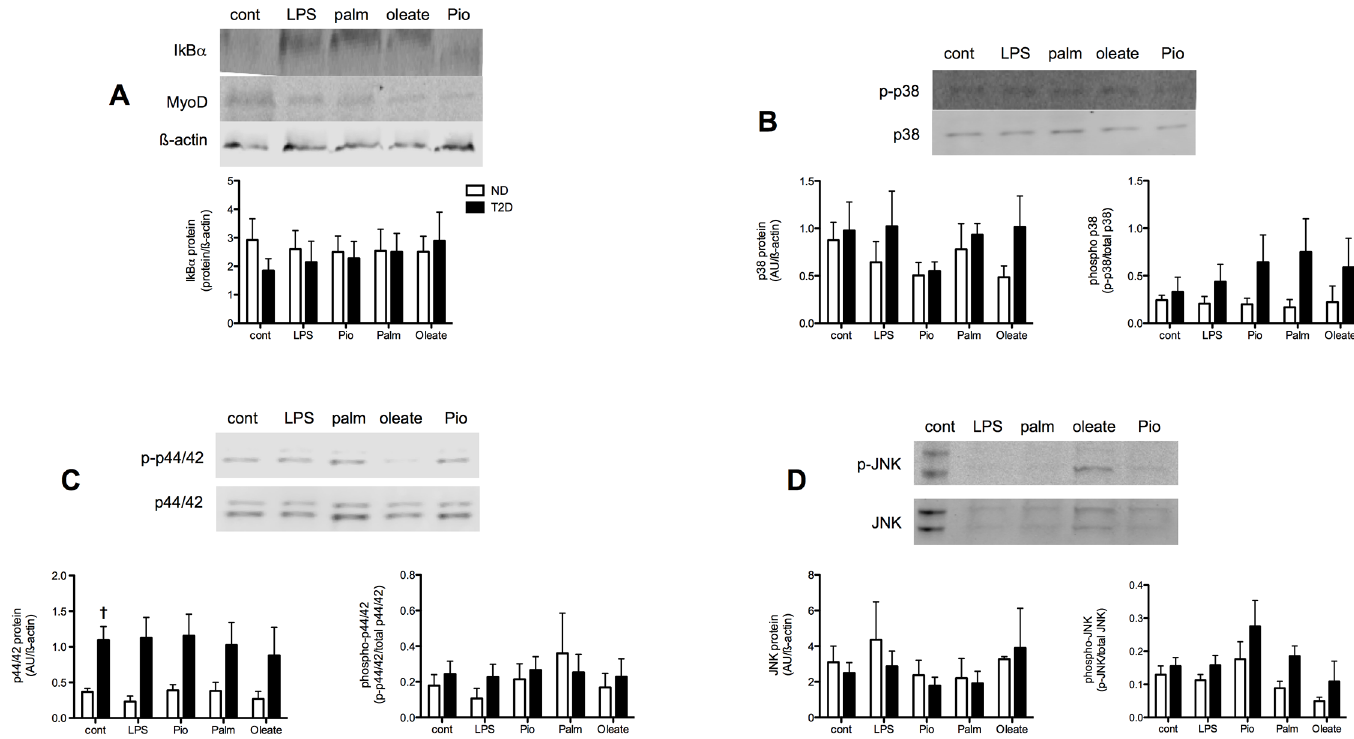
Fig 5. Regulation of inflammatory signaling in hSMC. ND (open bars) and T2D (solid bars) cells extracted after 48 hr treatment with LPS, Pioglitazone (Pio), palmitate or oleate. Results expressed relative to untreated control for each individual set of cells, Ave + SEM. (A) IkBa protein, n = 7 – 12 and 6 – 15 for ND and T2D, respectively. (B) Total and phospho-p38, n = 6 – 14 and 5 – 8. (C) Total and phospho-p44/42, n = 7 – 13 and 7 – 11. (D) Total and phospho-JNK, n = 9 – 12 and 3 – 8. * p < 0.05 T2D vs ND. † p < 0.05 T2D response vs ND response